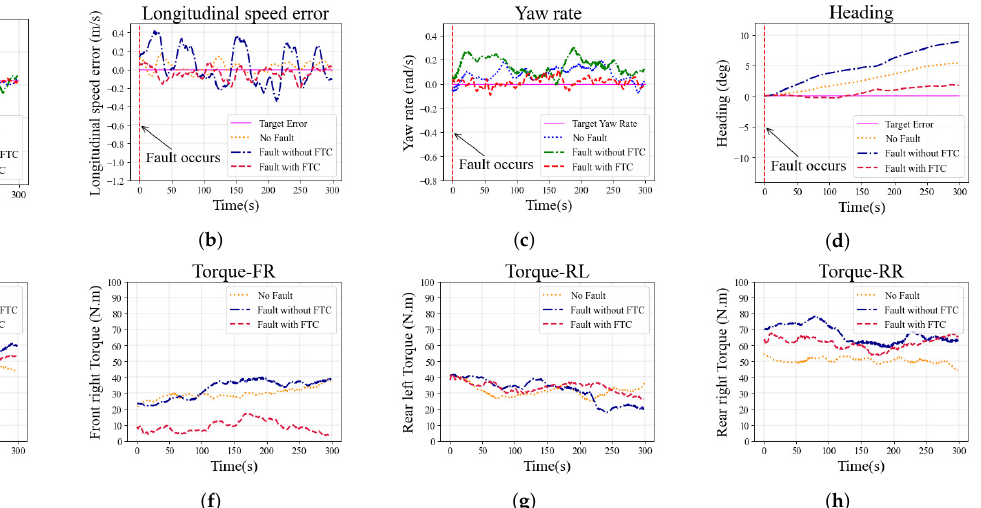
Figure 7. Simulation results in the straight scenario with fault F ∗ tudinal speed; ( b ) Longitudinal speed error; ( c ) Yaw rate; ( d ) Heading; ( e – h ) Torque on each wheel (front left, front right, rear left, and rear